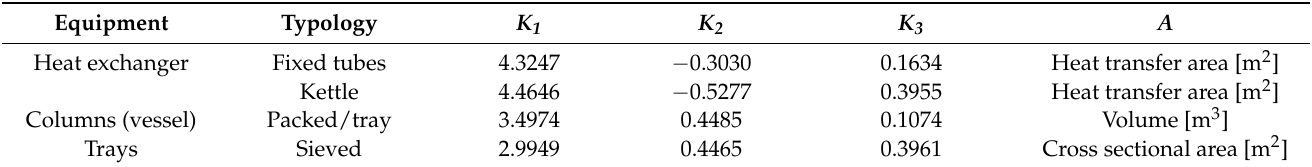
Table A1. Equipment cost in base conditions parameters.